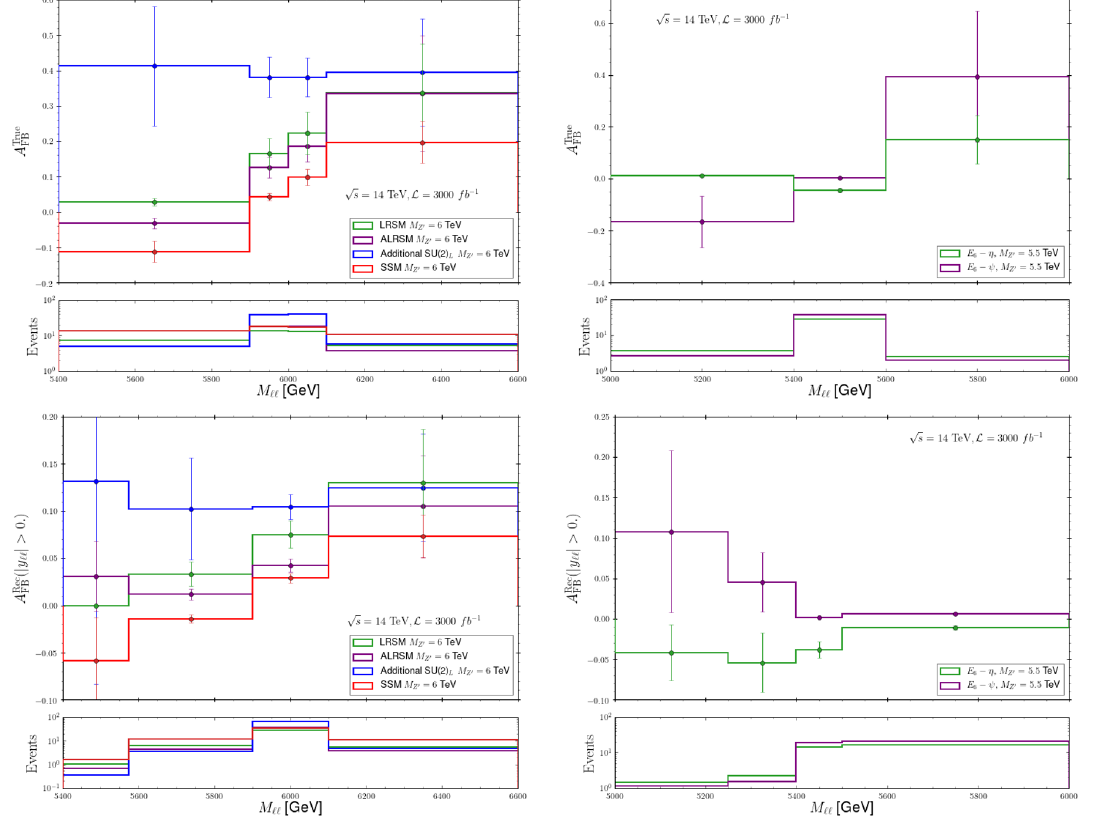
Figure 5 . Dependence of the forward-backward asymmetry on the invariant mass M ‘‘ of the lepton pair produced in NC Drell-Yan processes at the HL-LHC, in models featuring both a W 0 and a Z 0 boson (left panel), and in U(1) 0 models (right panel). Predictions are shown for the true (top row) and reconstructed (bottom row) asymmetries. In the lower panels of each subfigure, we show the number of events populating a given bin, which is related to the associated uncertainty according to eq.